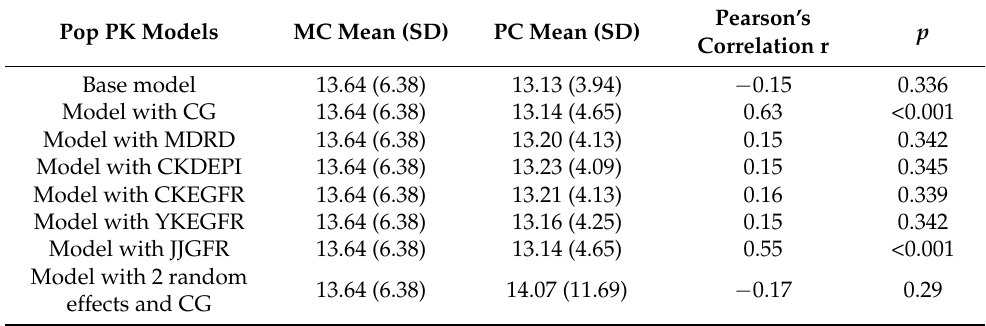
Table 5. Pearson’s correlation between observed vs. predicted vancomycin concentrations with different methods to estimate the GFR in pop PK models, n =